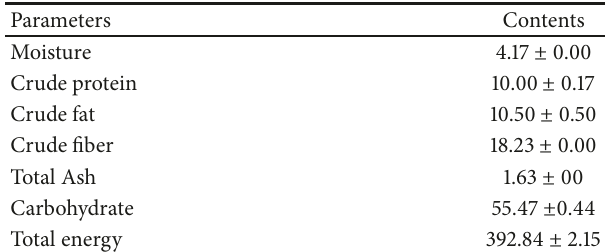
Table 1: Proximate composition of cactus pear seed flour (g/100g) dry weight